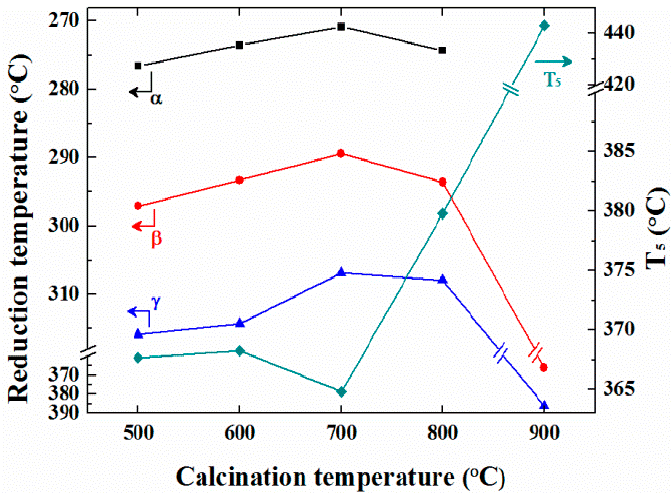
Figure 4. CH 4 -TPR (temperature-programed reduction) profiles of ( A ) the non-activated, and ( B ) activated Pd/ZrO 2 (x) catalysts.